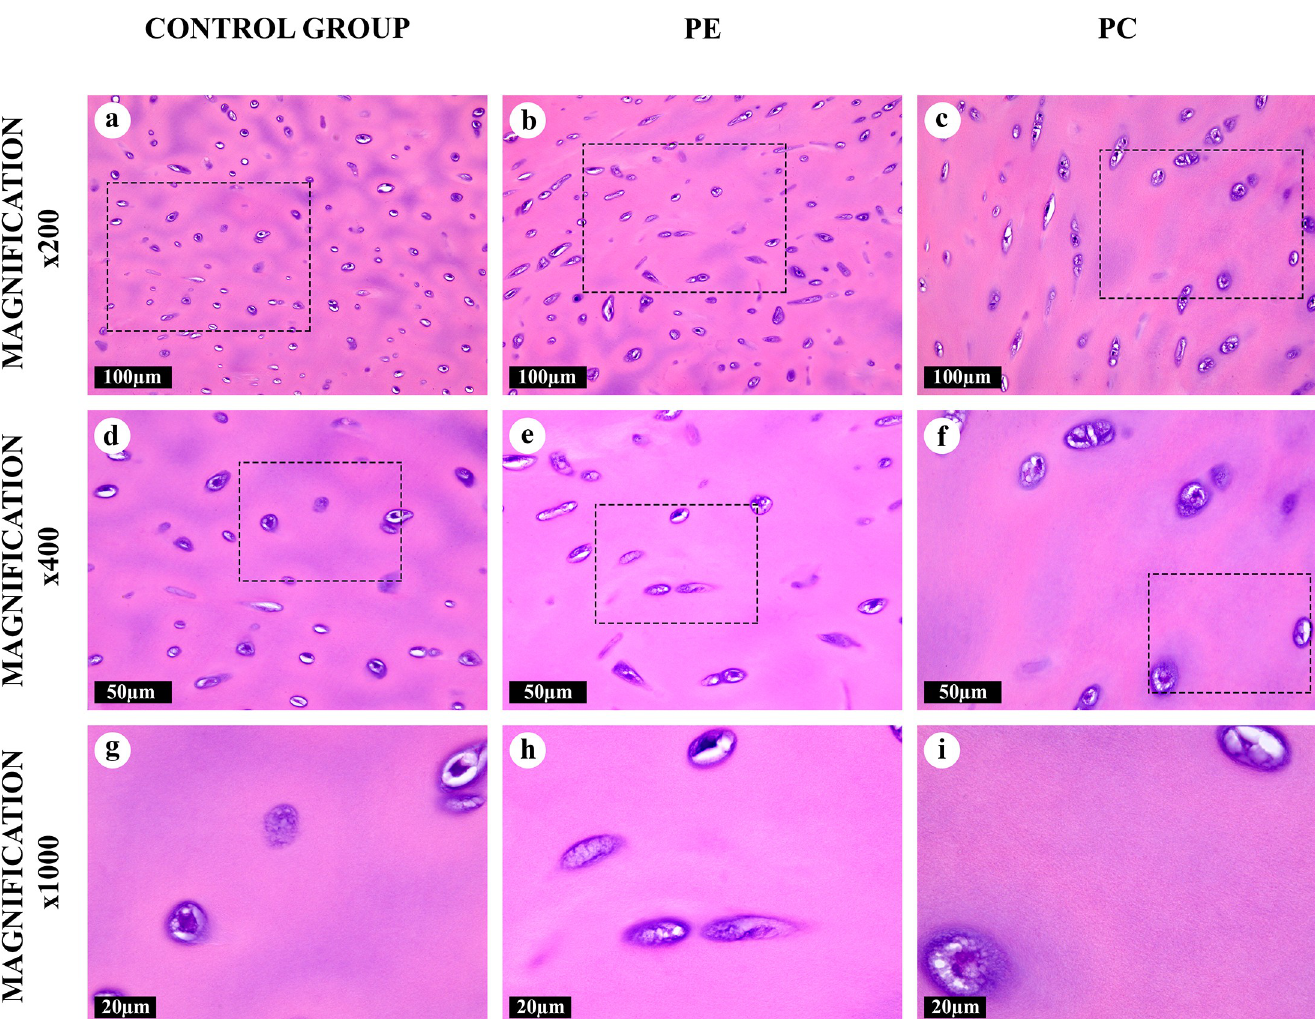
Fig 1. Intact matrix of the costal cartilages, hematoxylin and eosin. Homogenous matrix with chondron structure. The territorial matrix was eosinophilic, the interterritorial matrix was weakly basophilic. The capsular (pericellular) matrix was strongly basophilic. Some chondrocytes contained vacuoles and formed isogenous cell